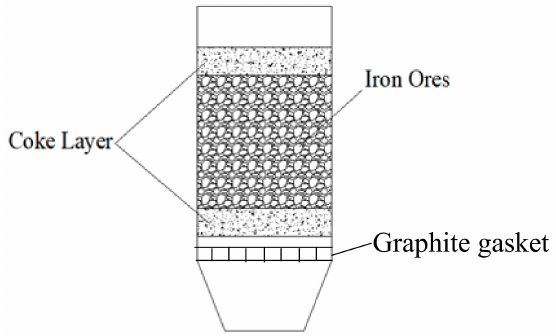
Figure 2. Sketch of a vertical section through the sample holder.